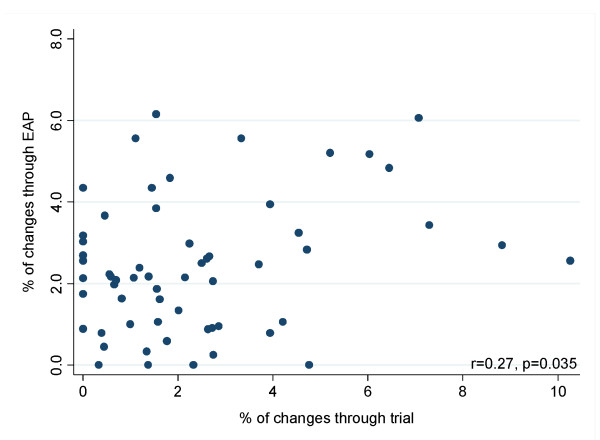
Regimen changes involving an experimental antiretroviral through clinical trials or expanded access programs (EAP) in each clinical centre.